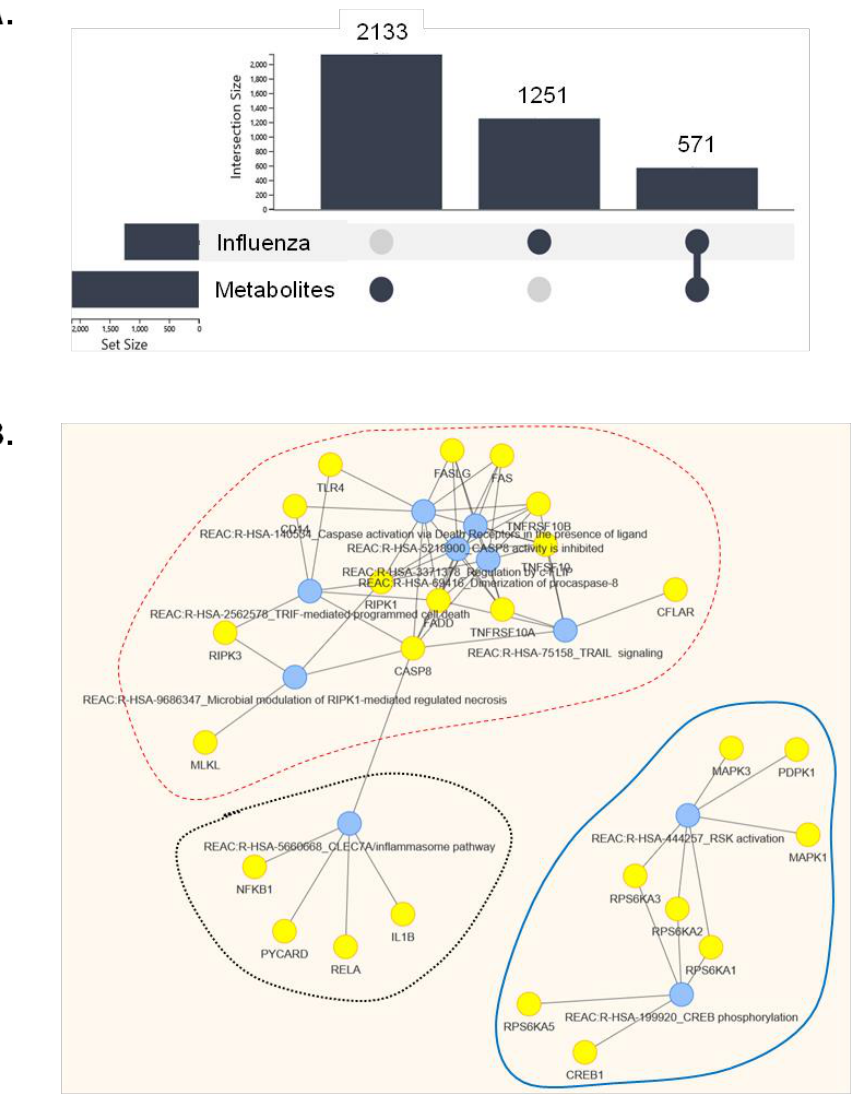
Figure 7. Bioinformatics-based prediction of pathways that intersect Primula metabolites and influenza-associated gene/protein terms. ( A ) Graph showing the number of genes/proteins associated with influenza (n = 1251), with phytochemicals that have been identified in Primula (metabolites, n = 2133), and their intersection (n = 571). ( B ) Enrichment of the intersection gene terms identified in (A) for Reactome molecular pathways using data p value correction cut-off 0.01. The ten most-enriched pathways and their interactions are shown. Three main clusters were identified: a cell death/cytolysis-related cluster (framed with dotted red line), inflammasome pathway (circled by a black dotted line) and an RSK/CREB-related signaling pathway (circled by a blue line).